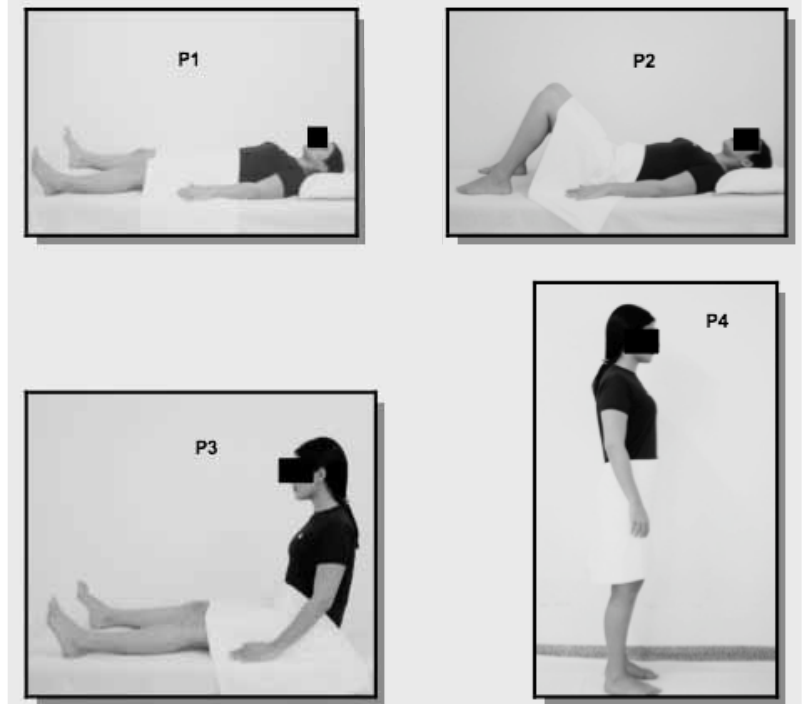
Figure 2 - Pelvic floor muscle assessment using manometry testing in four different positions. P P : Sitting. P : 3 4